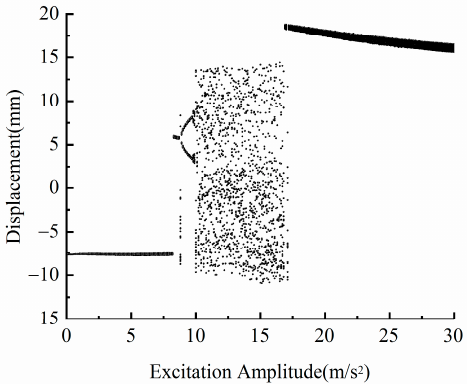
Figure 5. bifurcation diagram of the system with different excitation amplitudes. Figure 5. Bifurcation diagram of the system with different excitation